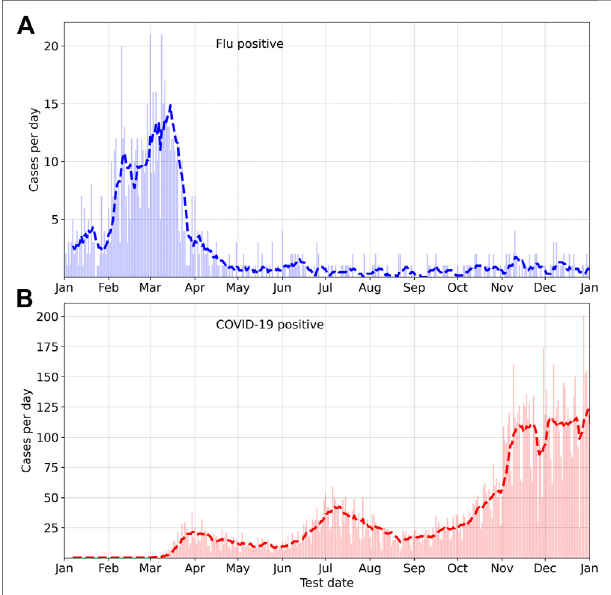
FIGURE 1 | Incidence of Flu and COVID-19 in the year 2020, from the Fitbit COVID-19 survey.